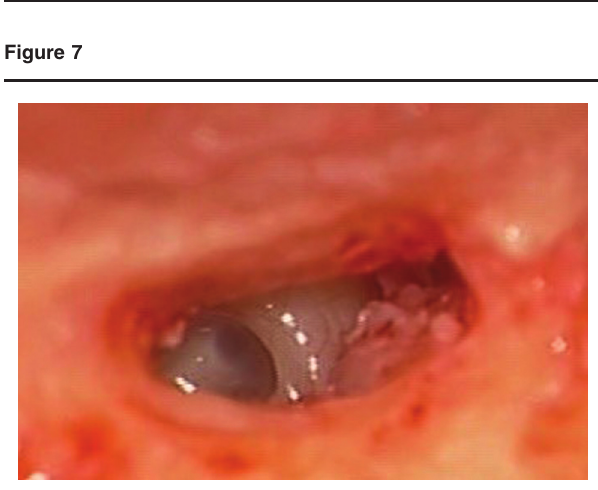
RWM almost fully visible. RWM, round window